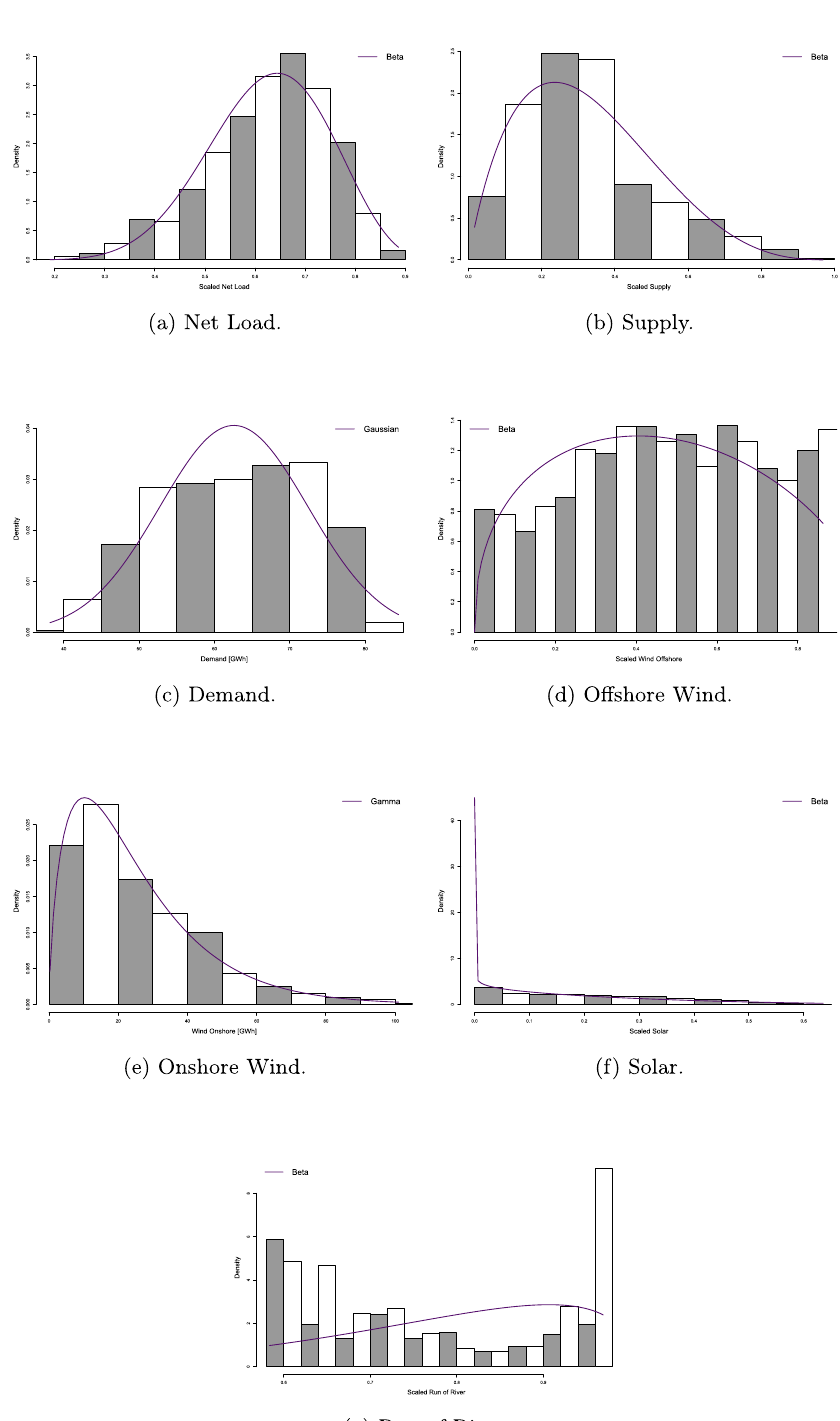
Fig. 5 The predicted distribution function and the observed empirical distribution function for all considered variables. We observe, that the selected distributions, in general, are a good approximation for the data. Note that if the selected distribution required values between 0 and 1, e.g. for the Beta distribution, the data was scaled in